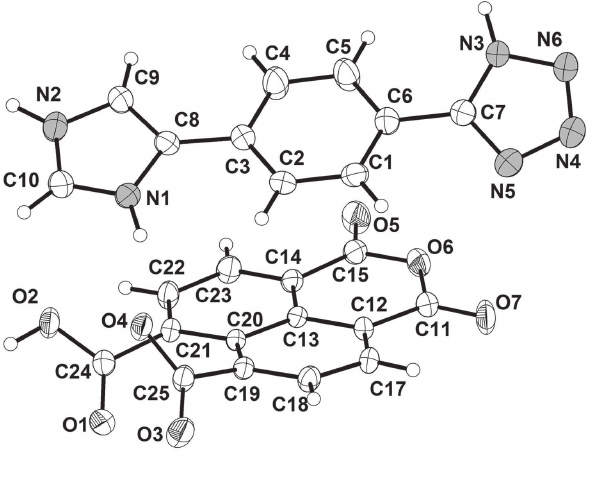
Table 1: Data collection and handling.